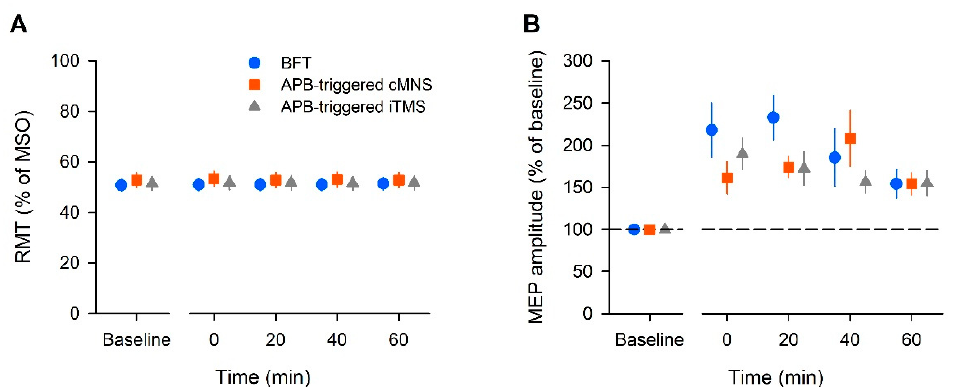
Figure 2. The averaged data of the resting motor threshold (RMT) ( A ) and amplitude of the motor- evoked potential (MEP) ( B ) in all the participants. The RMT is expressed as a percentage of the maximum stimulator output (MSO). The MEP amplitude is expressed as a percentage of the baseline value. Each plot and error bar represents the mean and standard error of the mean, respectively.